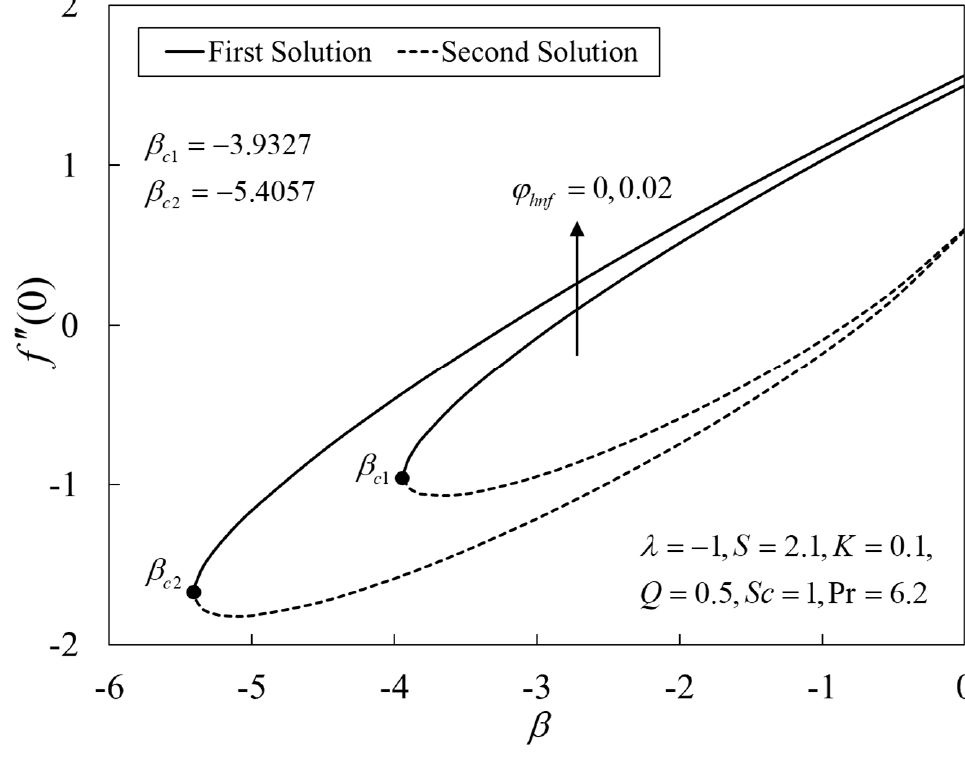
Figure 2. Plot of (0) f  against β . Figure 2. Plot of f (cid:48)(cid:48) ( 0 ) against β .